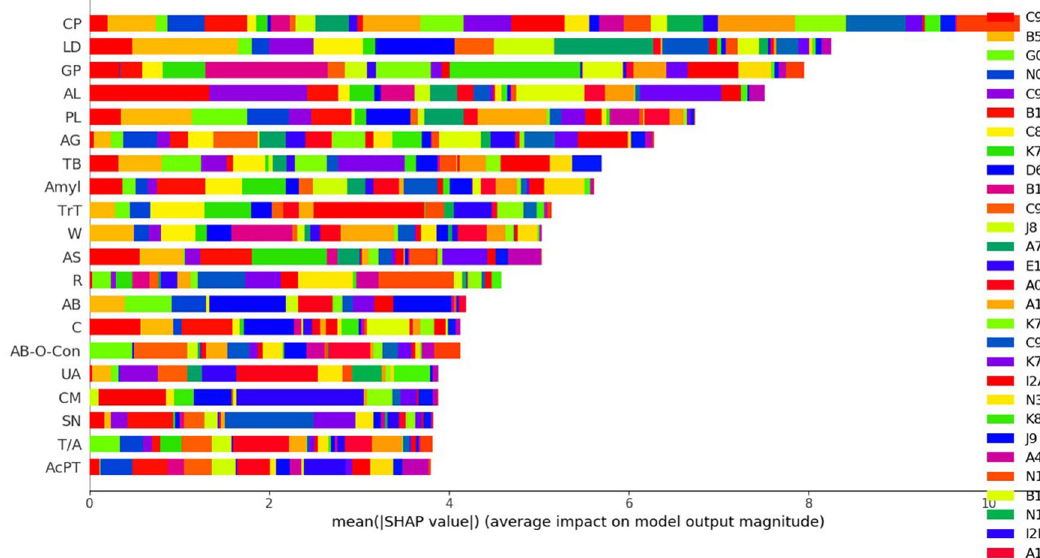
Figure 2. The mean SHAP method result between parameters and disease classifications in LightGBM.